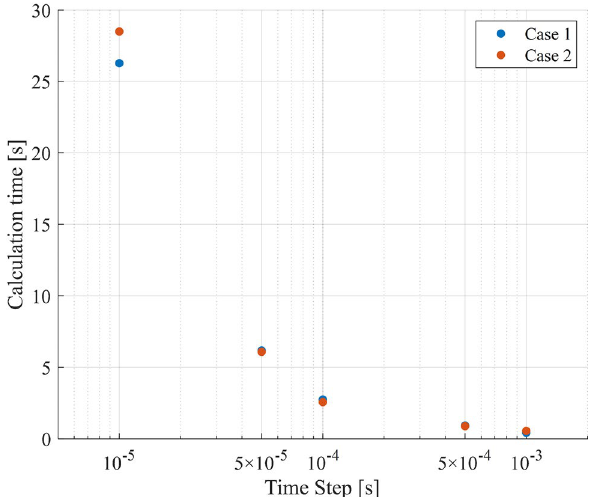
Fig. 11 Calculation times for 0.01[s] analysis with respect to differ- ent time